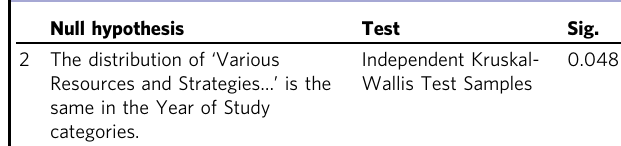
2 The distribution of ‘ Various Resources and Strategies …’ is the same in the Year of Study